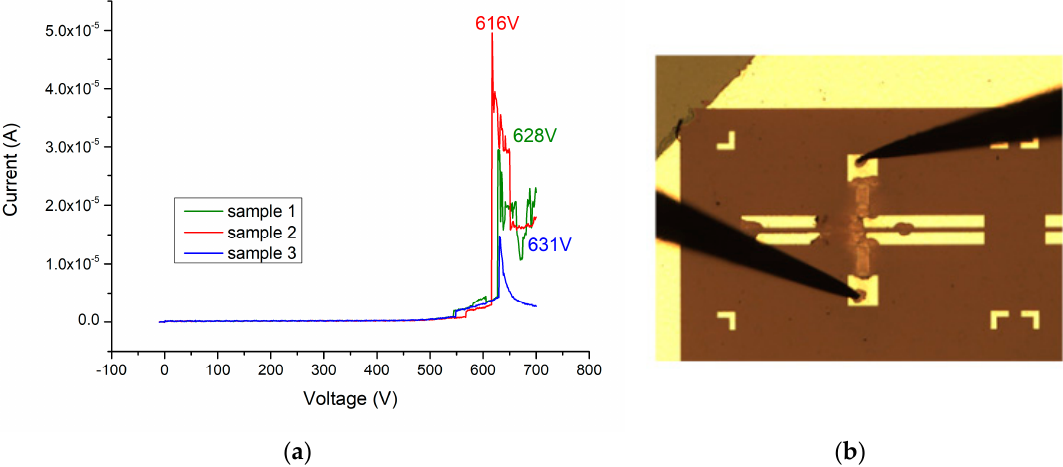
Figure 25. ( a ) I–V measurement results and ( b ) breakdown image of the MOSOM varactor (with a 341 nm thick Ga 2 O 3 thin film) without annealing.